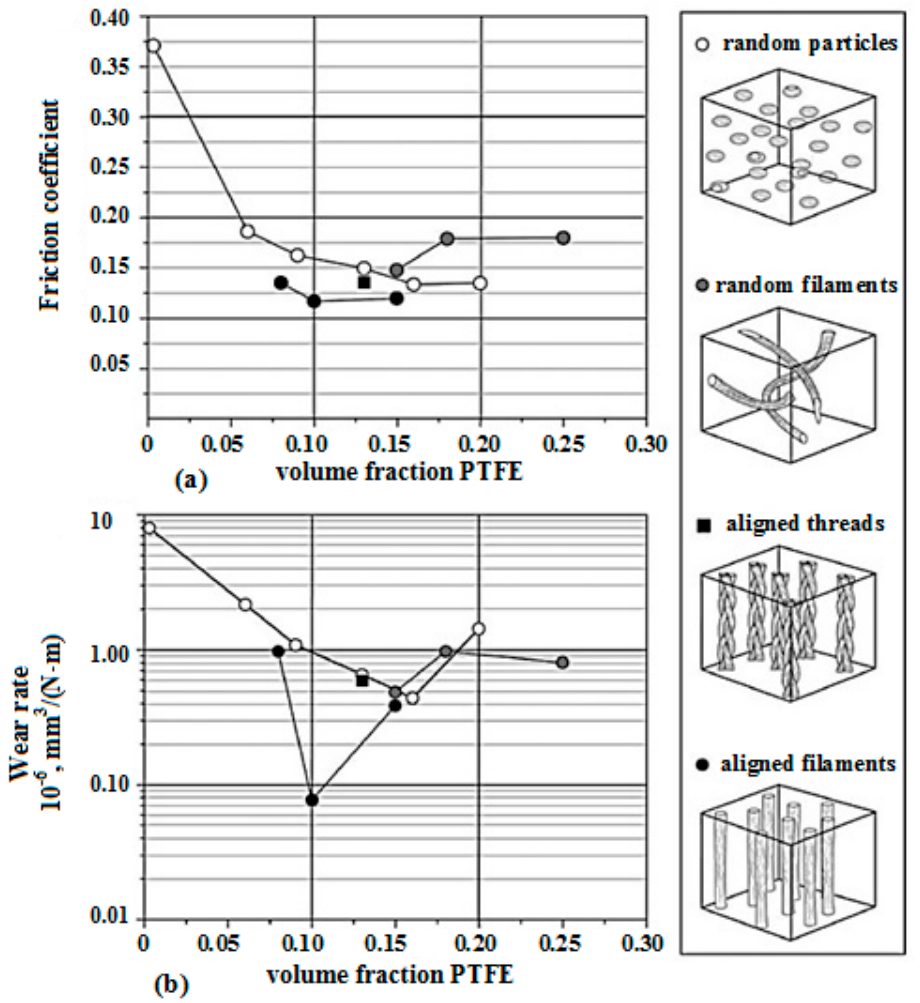
Figure 2. ( a ) Friction coefficient versus PTFE filler loading. At low loadings of aligned ePTFE filaments, the friction coefficient was slightly less than that of the powder filled composites at similar loadings. ( b ) Steady state wear rates plotted against PTFE filler loading. Composites with expanded PTFE filaments aligned normal to the sliding direction demonstrated the best wear rates; the performance of randomly oriented filaments was similar to the powder PTFE filled PEEK composites [3].